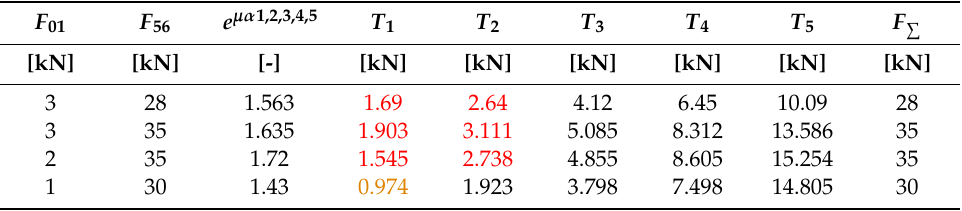
Table 2. Uniform tension distribution (simulation).